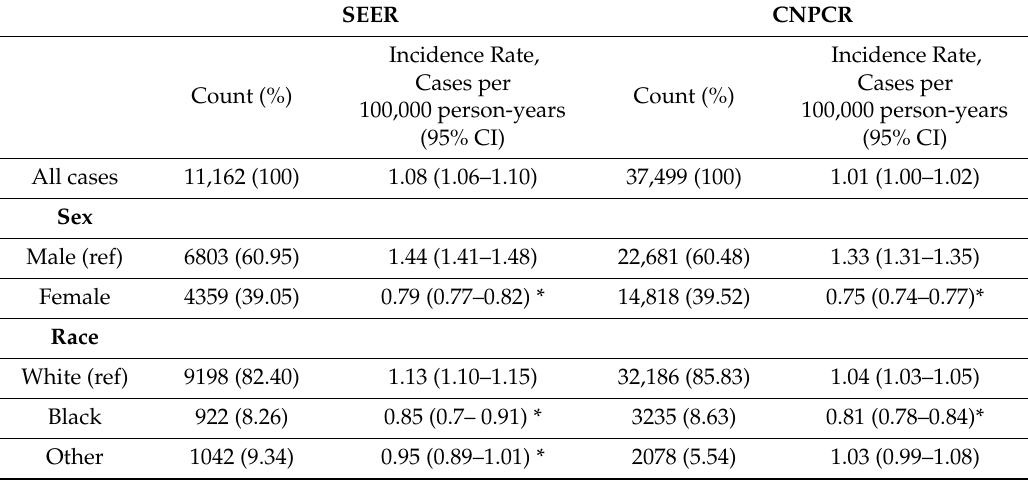
Table 1. Liposarcoma cases and age-adjusted incidence rates by demographic characteristics in the U.S. population, 2001–2016.